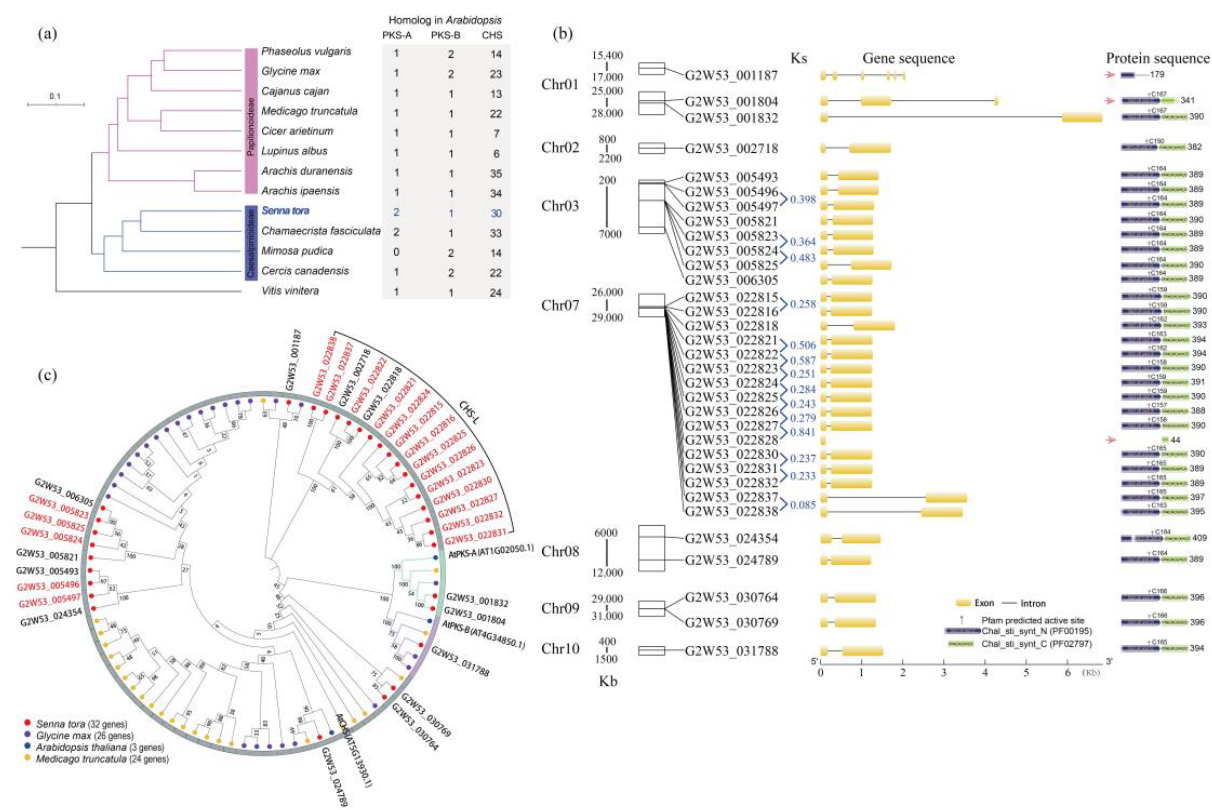
Figure 2. The genome-wide identification and analysis of the type III PKS superfamily genes. ( a ) The phylogenetic relationship and the number of type III PKS superfamily genes in Senna tora and other plant species in the Papilionoideae and Caesalpinoideae clades. ( b ) The distribution, structure, and domain of the type III PKS genes in the S. tora genome. The left side shows the linkage group or scaffold in which the gene is located, the gene ID and structure of type III PKS genes are displayed in the middle location, and the domains predicted by Pfam are given on the left side. ( c ) The unrooted phylogenetic tree shows the evolutionary relationships of the type III PKS protein sequences from